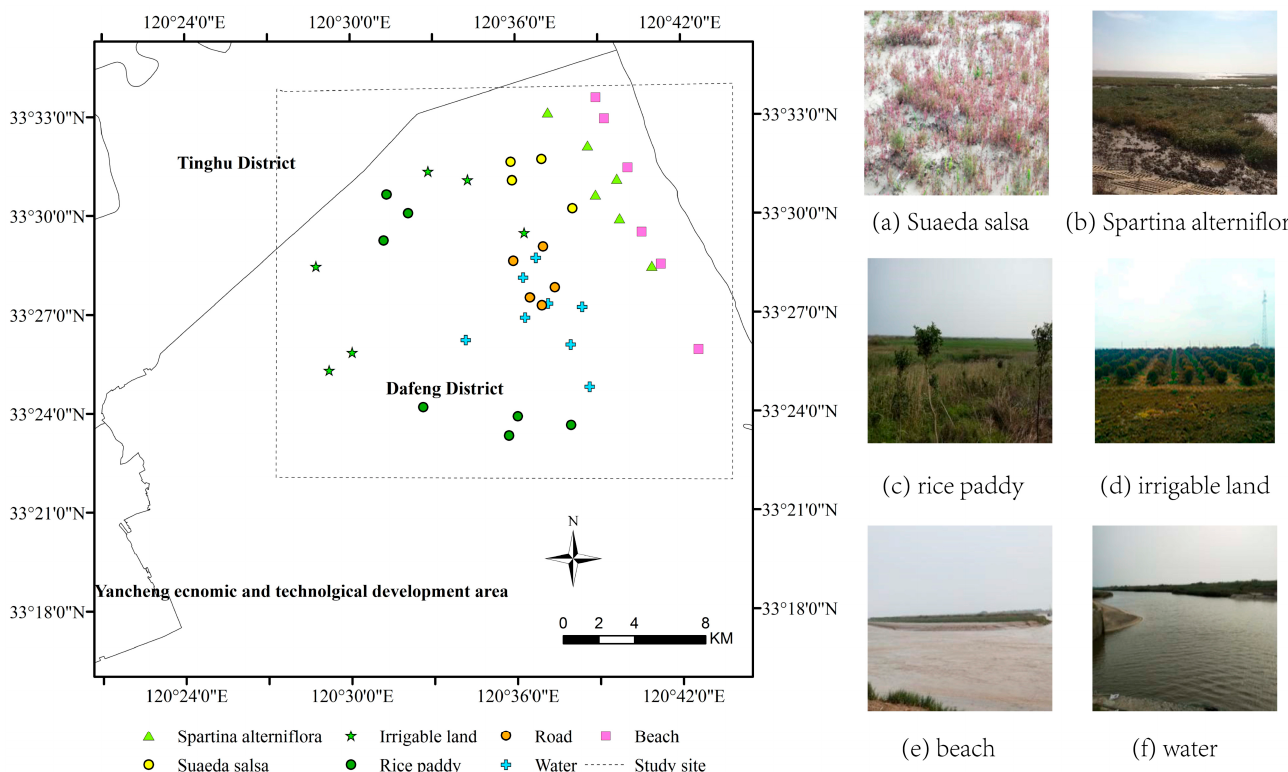
Figure 2. Field survey sites. ( Left ): the distribution of the field sites; ( a )–( f ): photos of Suaeda salsa , Spartina alterniflora , rice paddy, irrigable land, beach and water.